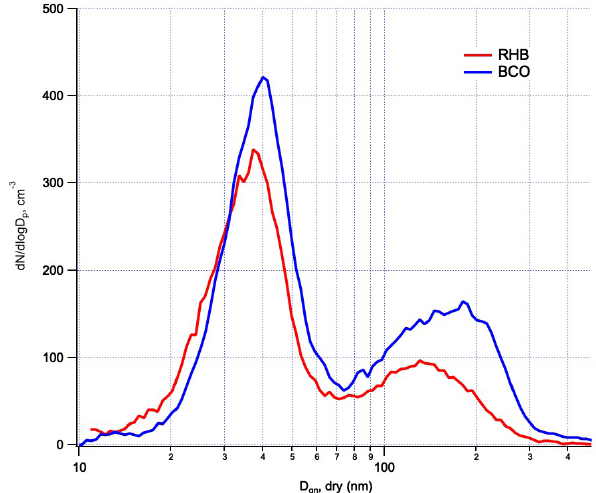
Figure 10. Comparison of aerosol number size distribution mea- sured on board the RV Ronald H. Brown ( RHB ) and at the Barbados Atmospheric Chemistry Observatory (BACO) during the compari- son period (24 January, 18:20–25 January, 23:40) when RHB was 20nmi to the east of BACO.